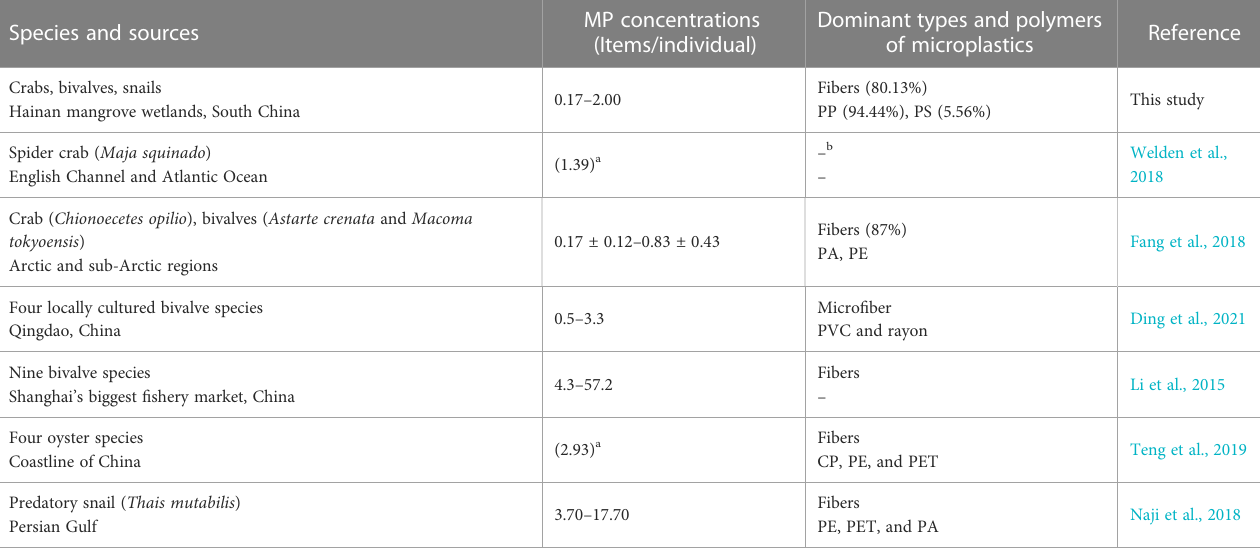
TABLE 3 Comparison of microplastic abundance in benthic species with previous